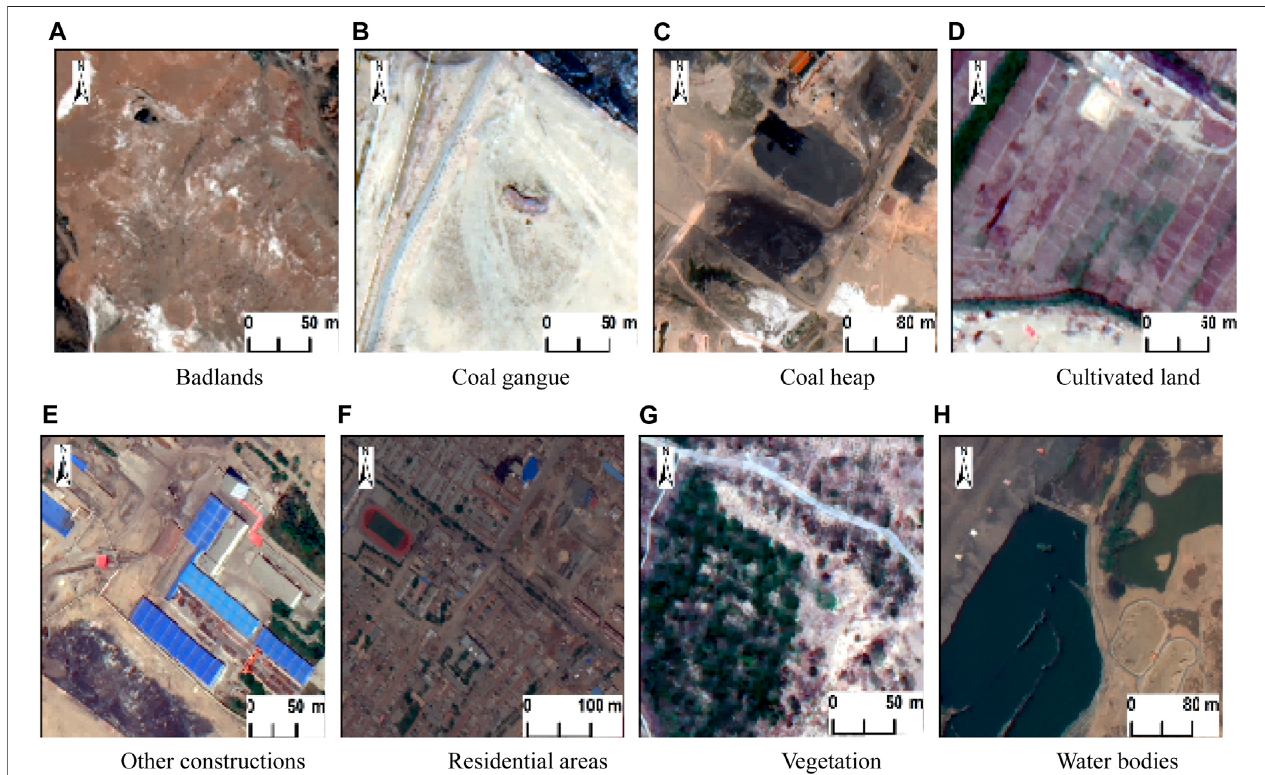
FIGURE 5 | Interpretation signs in WorldView-2 image. (A) Badlands, (B) coal gangue, (C) coal heap, (D) cultivated land, (E) other construction, (F) residential areas, (G) vegetation, and (H) water bodies.